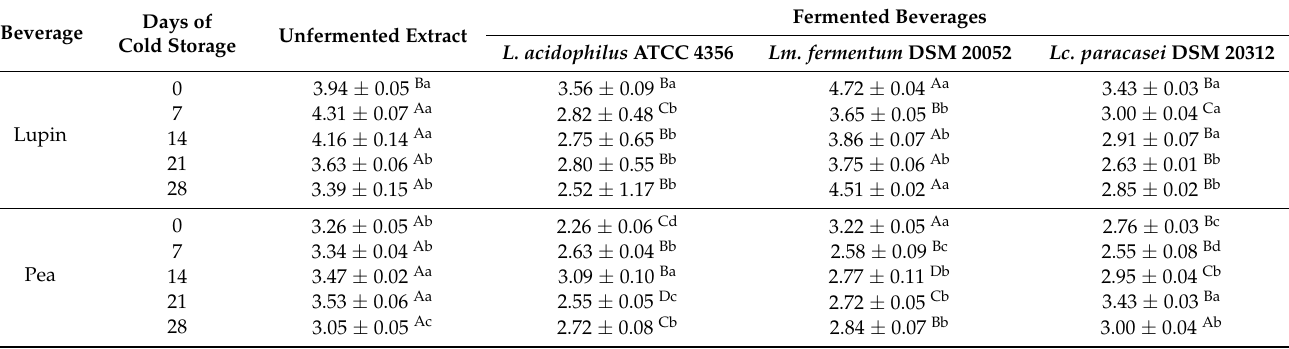
Table 8. Concentration of free peptides and amino acids (mg mL − 1 ) in fermented beverages and in unfermented water extracts during 28 days of refrigerated (4 ◦ C)